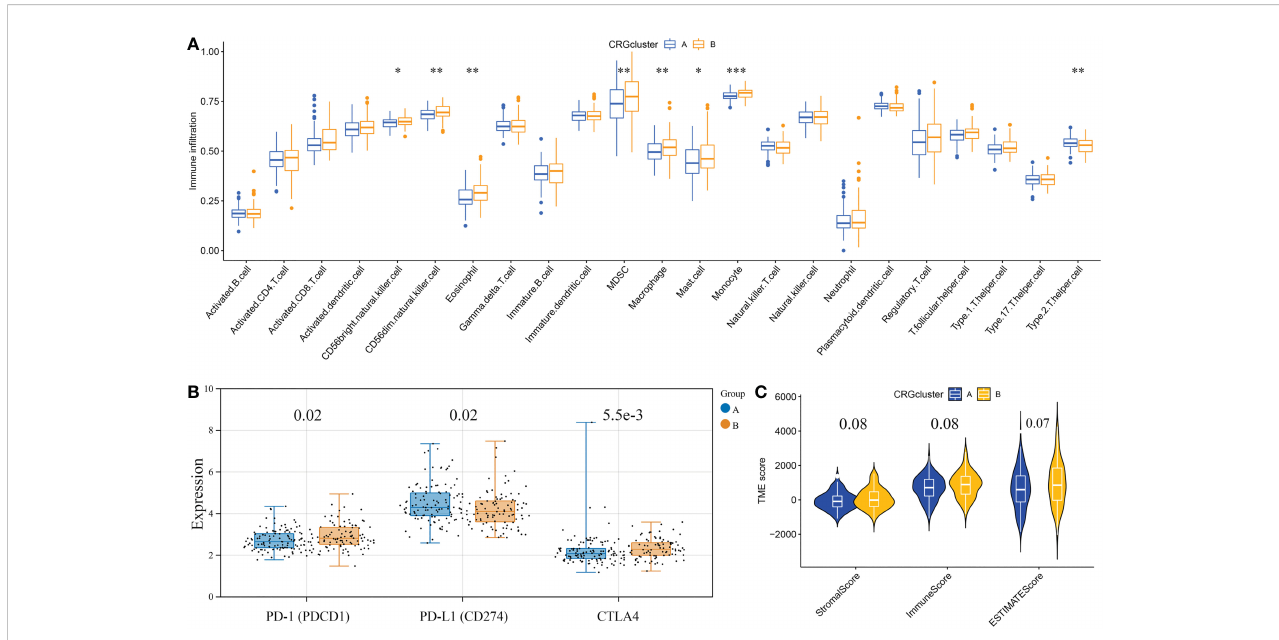
FIGURE 4 Correlations of the tumor microenvironment and the two cuproptosis subtypes. (A) The abundance of 23 in fi ltrating immune cell types in the two cuproptosis subtypes. (B) The expression levels of PD-1, PD-L1, and CTLA4 in the two cuproptosis subtypes. The blue boxes represent CRGcluster A, and the yellow boxes represent CRGcluster B. (C) The violin diagram shows the three kinds of TME scores in CRGcluster A and CRGcluster B. * p < 0.05, ** p < 0.01, *** p < 0.001 vs. CRGcluster